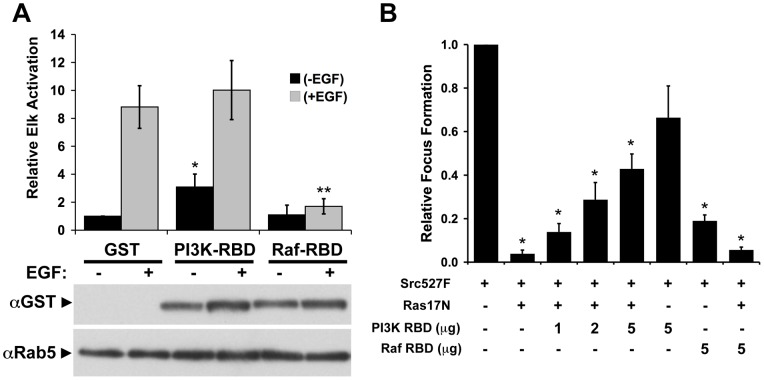
Biological activity of PI3KC2β versus Raf RBDs.(A) Expression of the Raf-RBD but not the PI3KC2β-RBD or GST alone inhibited EGF-stimulation of a Gal-Elk reporter assay [23]. GST-RBDs were expressed equally. GST alone migrated at a faster rate and was not visible in this image. Results represent the average relative activation ± S.E.M. from at least three independent experiments. (*p<0.05 compared to unstimulated GST, **p<0.01 compared to EGF stimulated GST). (B). PI3KC2β-RBD dose-dependently inhibits the effect of Ras17N on Src-mediated transformation. NIH/3T3 cells were transfected with 100 ng of SrcY527F expression construct in the presence or absence of Ras17N. Co-expression of the PI3KC2β-RBD reverses the inhibitory effect of Ras17N on Src transformation whereas the Raf-RBD does not. In contrast, expression of the Raf-RBD alone, but not the PI3KC2β-RBD, significantly inhibited Src-mediated transformation. The results represent the average relative focus forming activity ± S.E.M. from three independent experiments performed in triplicate. Asterisks denote samples that were significantly different from Src alone (*p<0.05).